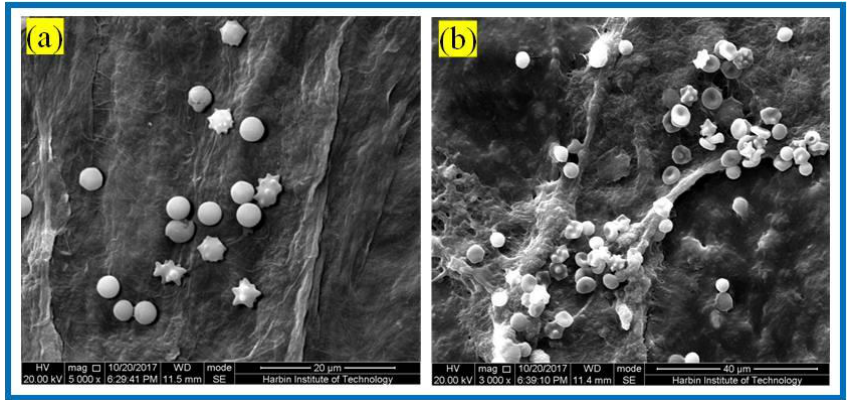
Figure 10. SEM of platelet adhesion on ( a ) BC membranes; ( b ):